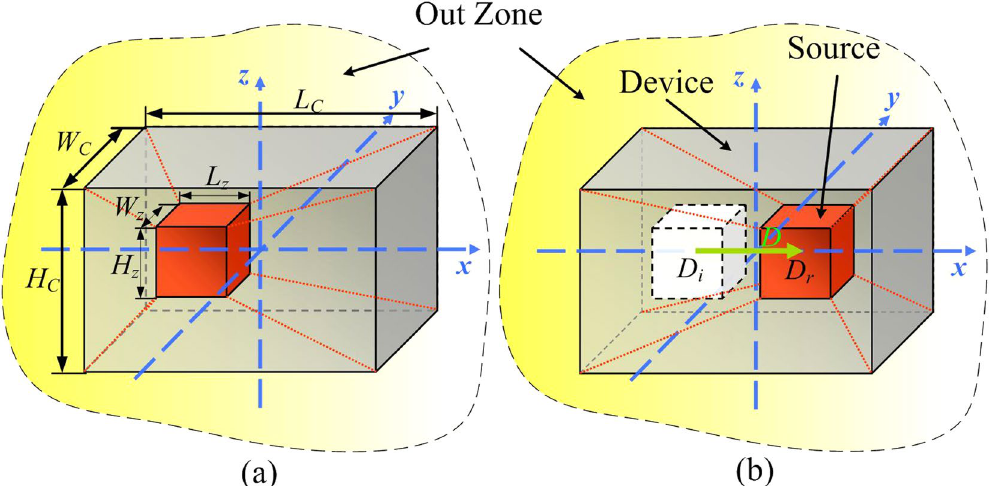
Figure 1. The schematic of the coordinate transformation in the device zone. In the illusional space ( a ), the heater is localized on the left part. In physical space ( b ), the heater is localized on the right. The six pyramids with red dotted lines as bevel edges in the illusional space are then transformed to the six pyramids in physical space correspondingly.